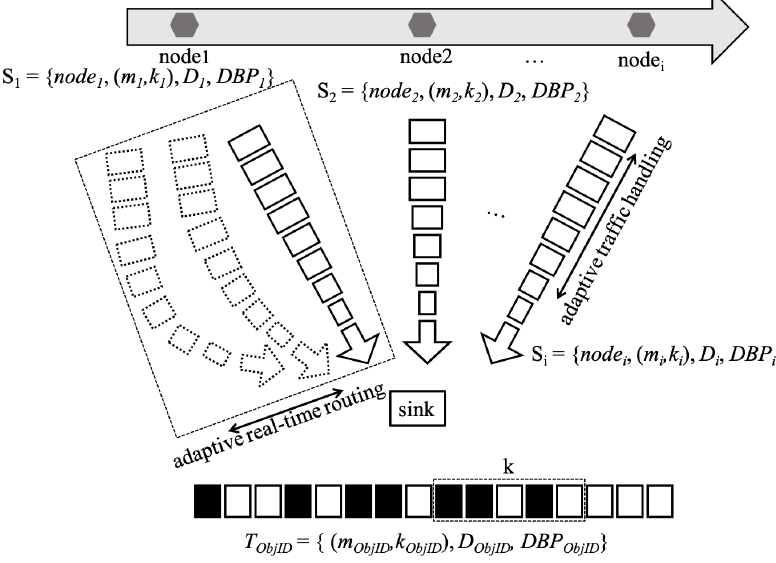
Figure 1. Overview of the proposed real-time